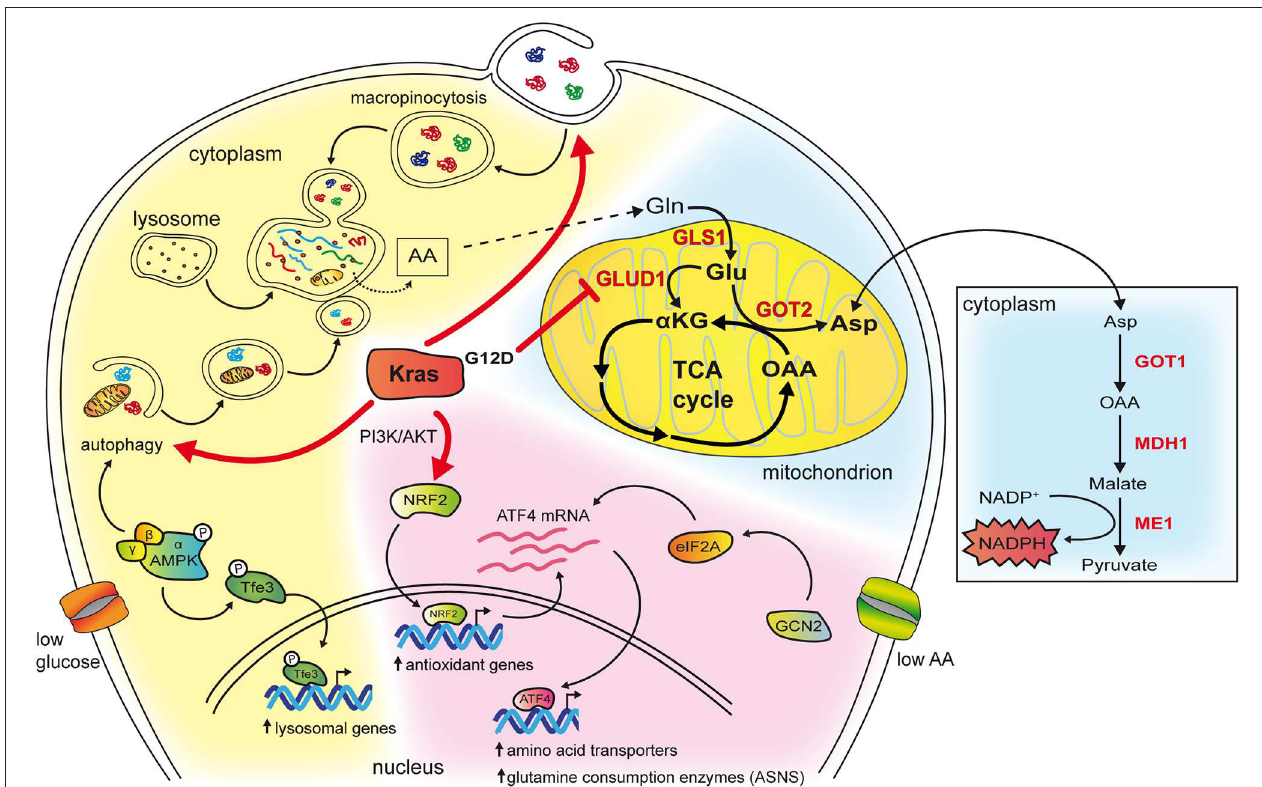
FIGURE 2 | The cartoon schematizes some of the effects of mutant Kras in reprogramming amino acid metabolism. The cytoplasm of the cell has been colored in blue in the background to highlight the role of mutant Kras in PDAC, in pink to represent pathways revealed in NSCLC, in yellow when the mechanisms are common to both tumor types. Kras potentiates both macropinocytosis and autophagy whose vesicles end up in lysosomes, a compartment that is frequently found enlarged in Kras mutant cancer cells. In, NSCLC, in condition of low glucose, this occurs by activating AMPK that phosphorylates Tfe3 resulting in its nuclear translocation and transcription of lysosomal genes. Moreover, AMPK activation increases autophagy initiation and maturation. Breakdown of macromolecules in lysosomes produce free amino acids available to biosynthetic and energy pathways. Among them glutamine can enter the TCA cycle in mitochondria (depicted on the right). In PDAC glutamine is consumed through an alternative pathway (highlighted in red and in the box on the right). In NSCLC, mutant Kras activates the PI3K/AKT pathway that, in condition of low glutamine, favors mRNA expression of the ATF4 transcription factor via the NRF2 factor. In addition, NRF2 is also a key regulator of genes involved in the antioxidant response. Under condition of asparagine deprivation, the GCN2-eIF2 pathway prompts transduction of the ATF4 mRNA into protein, which, in turn, activates the transcription of amino acids transporters and glutamine consuming enzymes. Among them, asparagine synthetase ASNS catalyzes the synthesis of asparagine from glutamine. Asparagine levels and ASNS control proliferation, mTORC1 activation and suppress